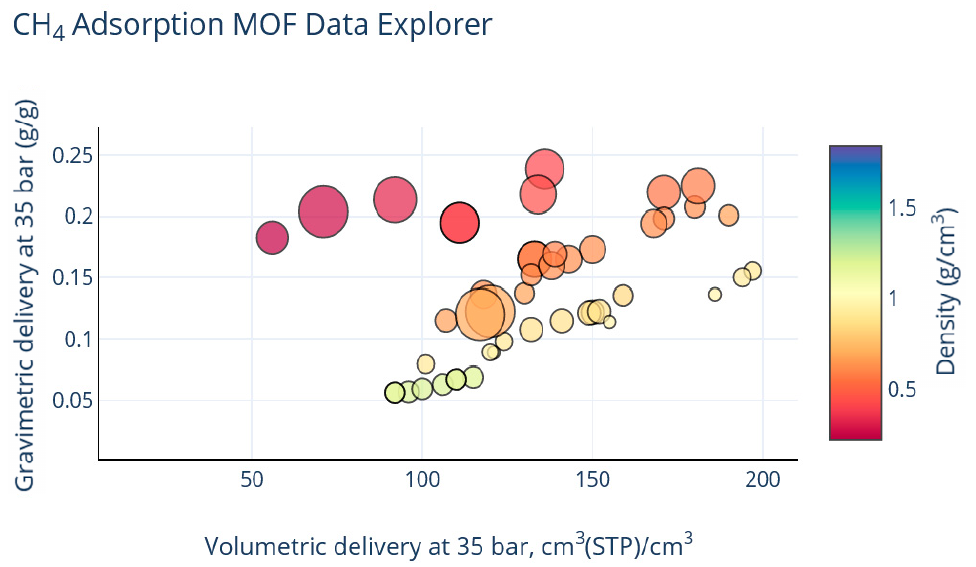
Figure 8. QSPR for CH 4 storage in MOFs. CH 4 volumetric and gravimetric uptakes at 298 K and 35 bar. Each point represents a MOF. The data points are color-coded for MOF density, and the diameter of each circle represents the largest cavity diameter (LCD) of each MOF.